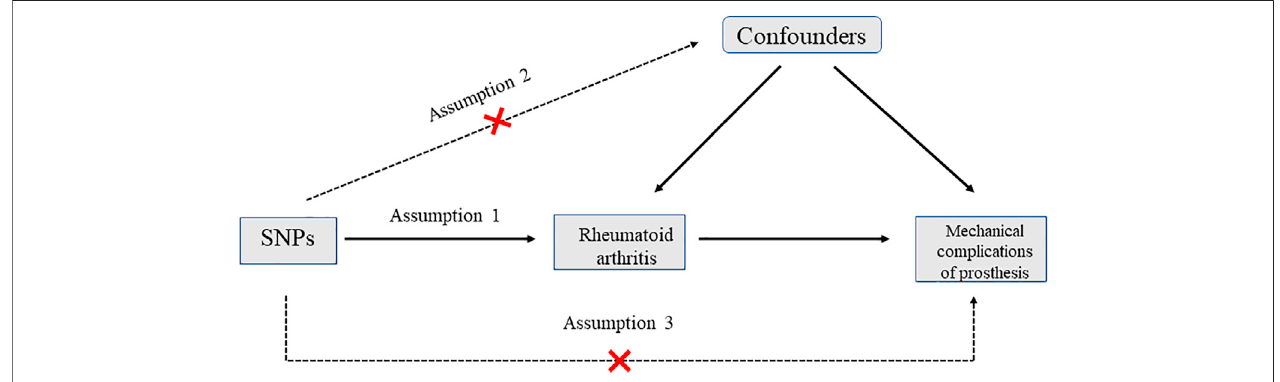
FIGURE 1 | Diagram for Mendelian randomization (MR).There are three assumptions that should be met in MR analysis: fi rst, SNPs should be strongly associated with the exposure; second, selected SNPs should be independent of confounders; third, SNPs should affect the outcome only by the exposure rather than via a direct correlation. SNP: single nucleotide